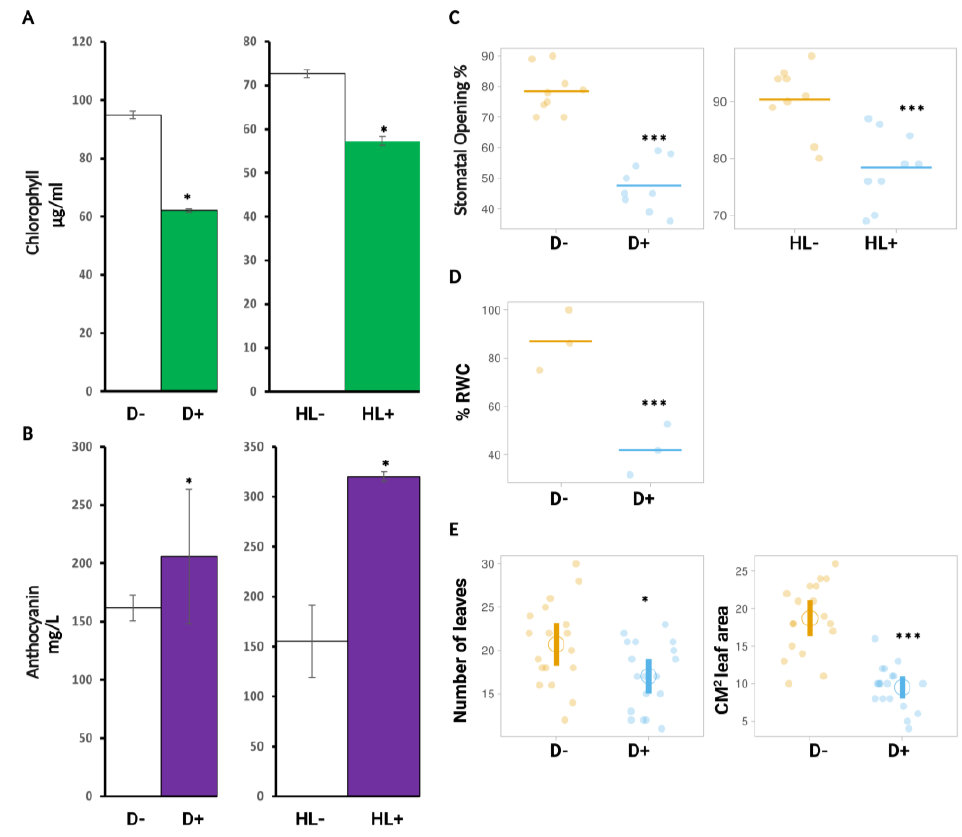
Figure 2. D and HL affect chlorophyll content, anthocyanin, stomatal opening, relative water content, and leaf growth. ( A ) Total chlorophyll from WT leaves after D stress treatment (left) (D- no D stress/control and D+ = D stressed), and after HL stress treatment (right) (HL- = no HL